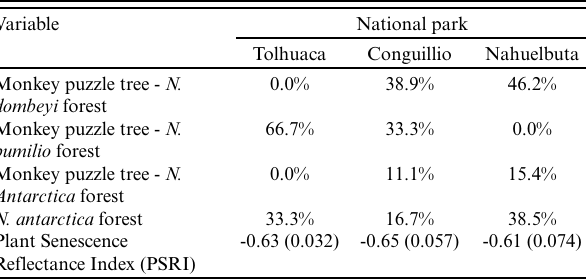
Table 1 . Variables characterizing the habitat of Magellanic Woodpeckers ( Campephilus magellanicus ) in the study area national parks, including forest type and the plant senescence reflectance index (PSRI) positively associated with tree decay stage. Forest type variables represent the percentage of plots being categorized as belonging to a particular forest type. All habitat variables were measured within 100 m around point counts used to monitor abundance of woodpeckers. The percentage of points surveyed in each forest type, as well as the mean (SD) of PSRI is shown for each national